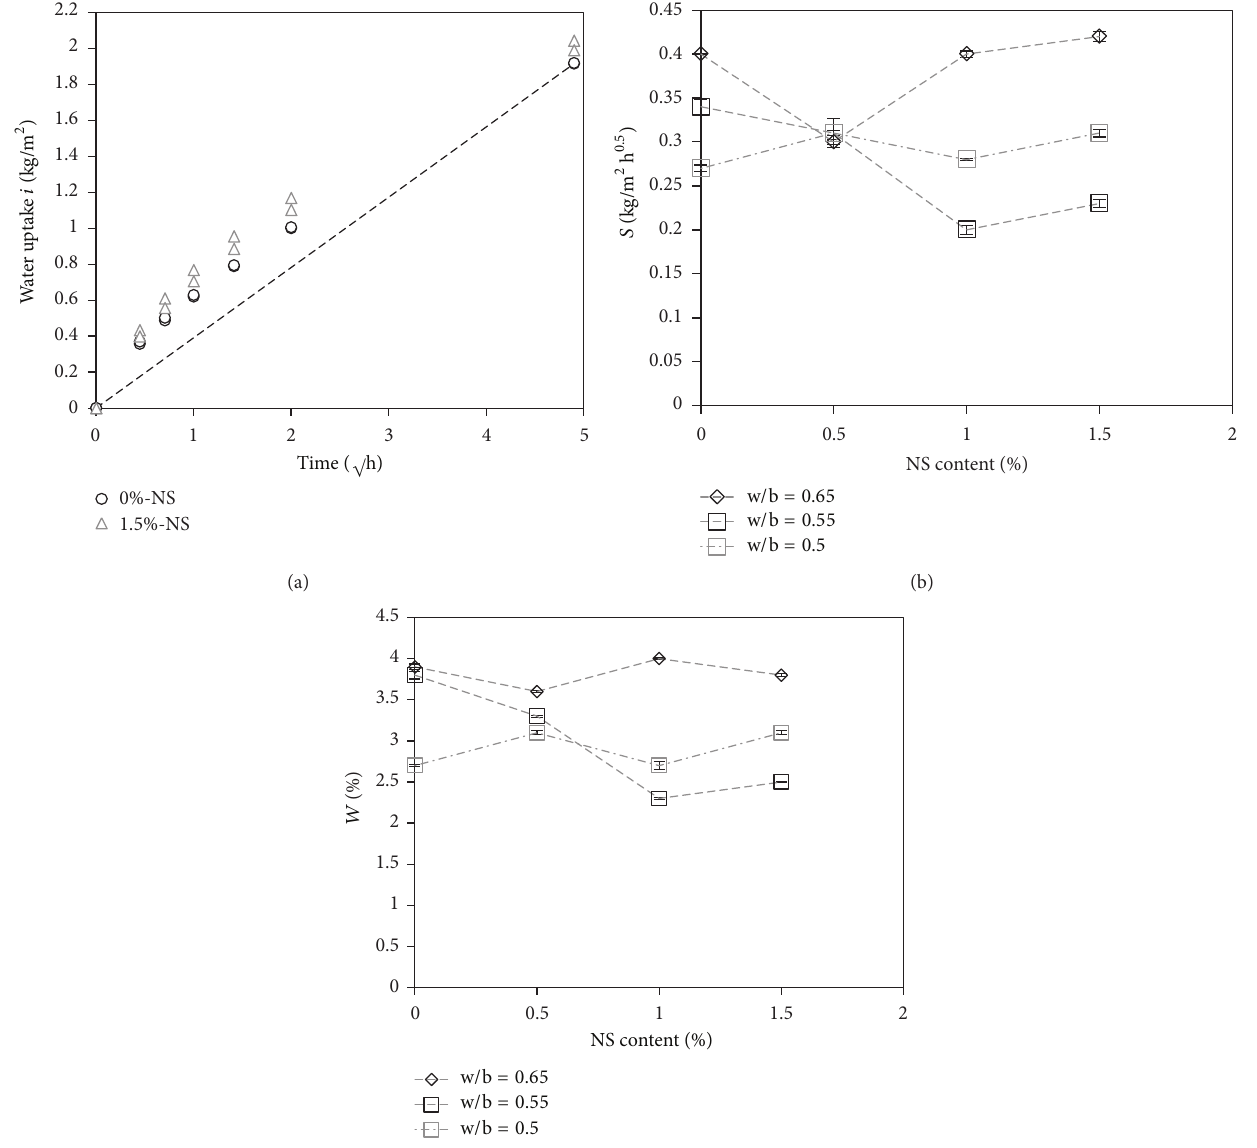
Figure 5: (a) Example of water uptake as a function of square root of time for w / b = 0.65 . (b) Sorptivity coefficient and (c) water absorption of concrete as a function of NS